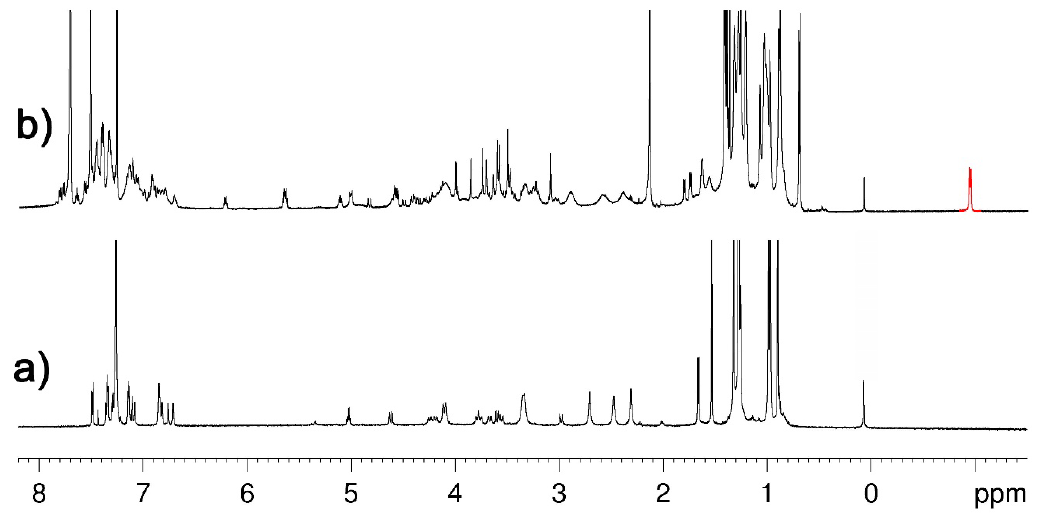
Figure 5. 1 H NMR spectra (600 MHz, CDCl 3 , 298 K) of: ( a ) ( R / S )- 4 . ( b ) 1:1 mixture (3 mM) of ( R / S )- 4 and ( S )- 9 + ∙B(Ar F ) 4 − . Marked in red the doublet attributable to the methyl group of the axle shielded inside the calixarene cavity.